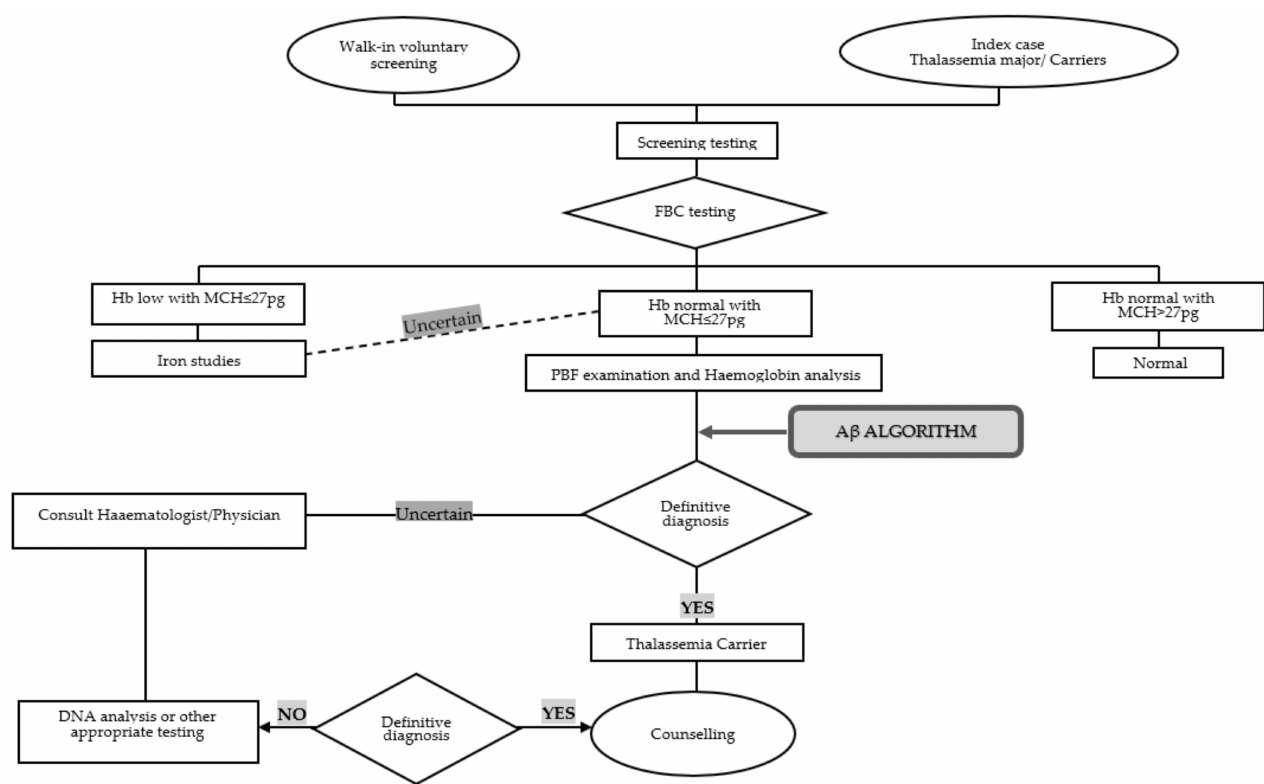
Figure 4. Flowchart representing the αβ -algorithm incorporated into the screening algorithm for voluntary and cascade screening in Malaysia’s Clinical Practice Guideline for Management of Transfusion Dependent Thalassaemia [4].